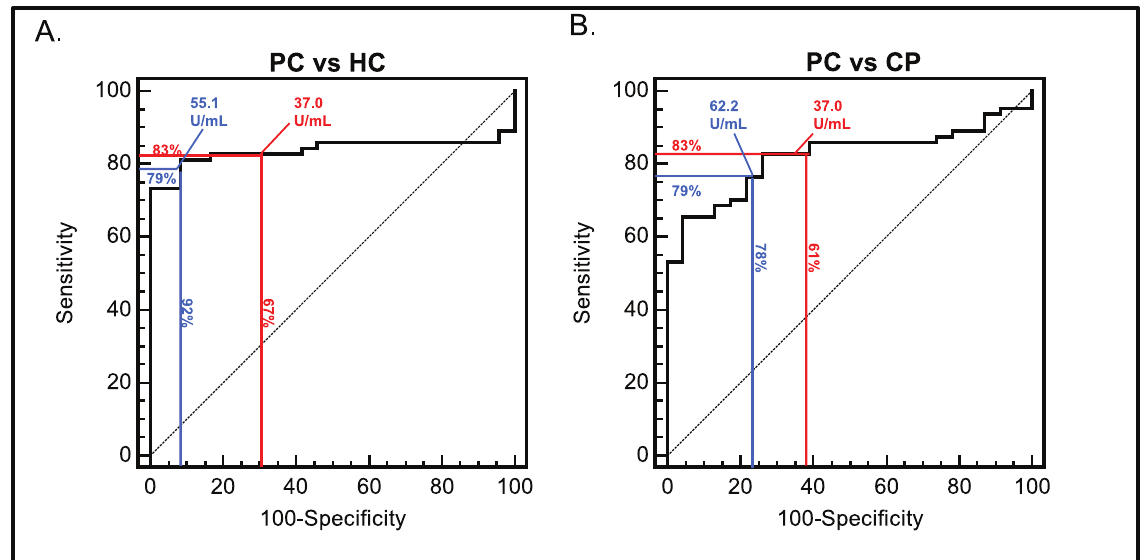
Figure 1. Reciever Operating Chacteristic curves comparing CA19-9 at its clinical cut-off of 37 U/ml and optimal cut-off of 55.1 U/ ml in treatment naı¨ve group. ROC curve analyses for assessing the ability of CA19-9 to differentiate PC form HC (panel A) and PC from CP (panel B) at its clinical cut off (37 U/ml) (red line), and optimal cut-off (55.1 U/ml) (blue line). At a cutoff of 37 U/mL, CA19-9 differentiated treatment naı¨ve PC patients from healthy controls with sensitivity, specificity of 83% and 67%, while sensitivity and specificity of 79% and 92% was observed at 55.1 U/ ml. In case of PC vs CP patients, sensitivity and specificity of 61% and 83% were observed at clinical cut-off while at optimal cut-off 62.2 U/ml sensitivity increased to 79% with specificity of 78%.